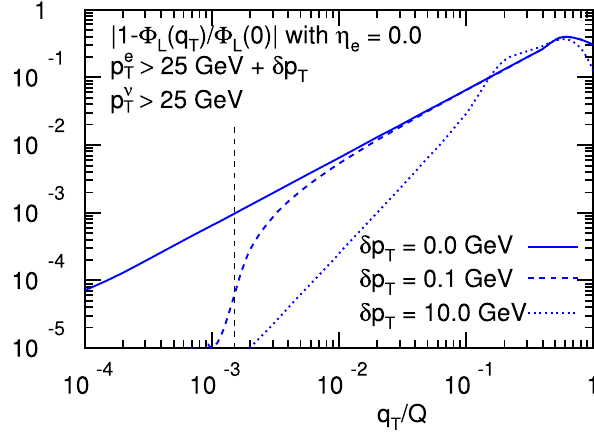
Fig. 16 Same as Fig. 15 for the fiducial cuts applied to ATLAS data set [6] for W ± -boson production ( Q = M W ) and different values of the lepton pseudo-rapidity η l . For the lepton momenta p l ,ν are required